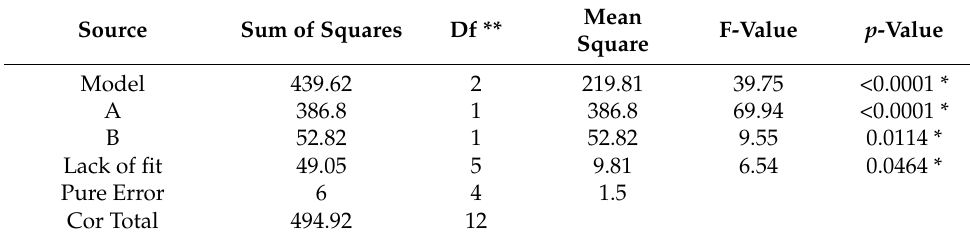
Table 5. ANOVA for the response optimization.